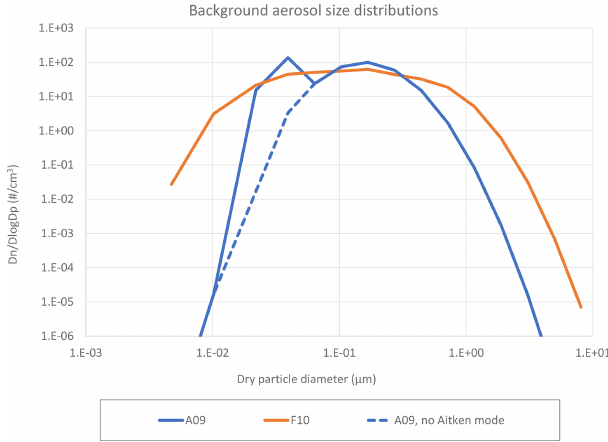
Figure 9. Model initial condition background aerosol size distri- butions. Solid blue – bimodal ammonium bisulfate size distribution defined by Ackerman et al. (2009); dashed blue – same with fine mode removed; orange – sea salt emission distribution from Fuentes et al.